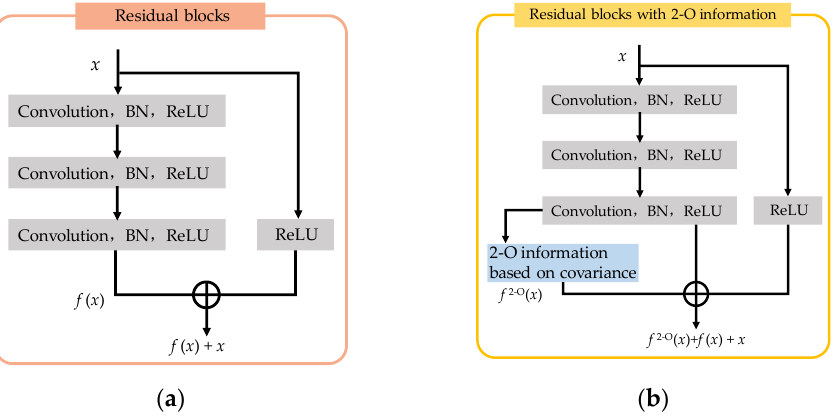
Figure 6. Generation of multi-order features in residual blocks: ( a ) Traditional residual block; ( b ) proposed multi-information residual block.